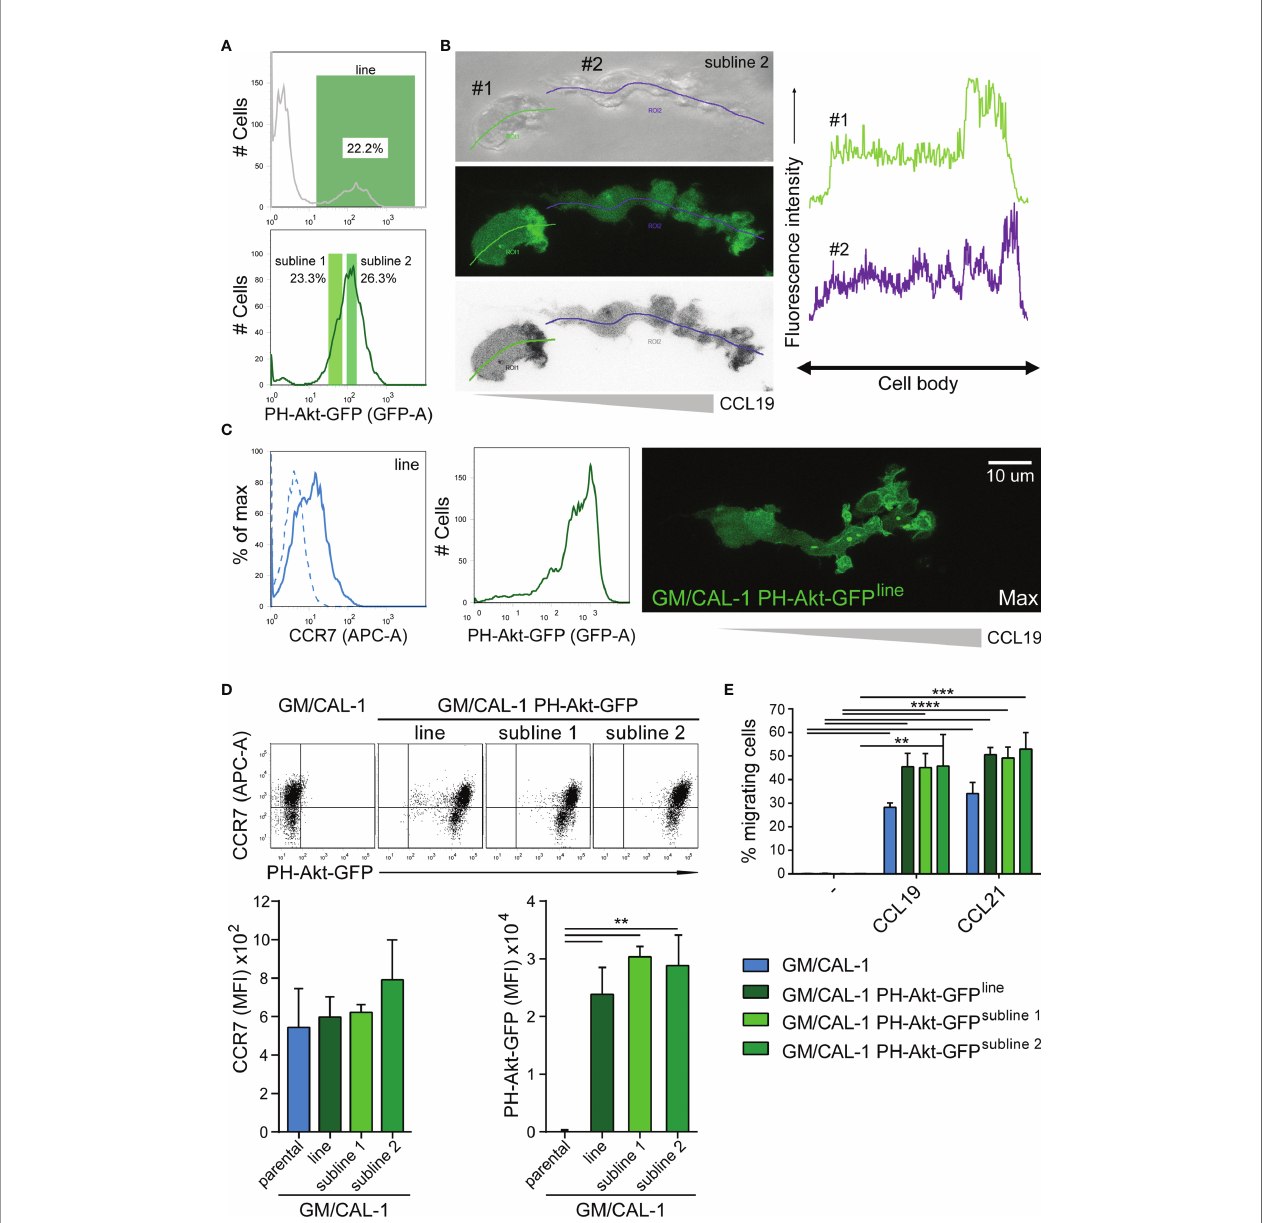
FIGURE 5 | Establishing stable cell lines to monitor PH-Akt-GFP, a biosensor for PIP 3 , in migrating R848-matured GM/CAL-1 cells. (A) Generation of a stable CAL-1 PH-Akt-GFP line and two sublines. CAL-1 cells were nucleofected with a plasmid coding for PH-Akt-GFP. After two weeks of selection, 22.2% of the cell population stably expressed PH-Akt-GFP and was bulk sorted (upper panel), revealing a stable line termed CAL-1 PH-Akt-GFP line . After 21 days in culture under G418 selection, two sub-lines were generated according to the gating strategy shown in the lower panel. (B) PH-Akt-GFP accumulates at the leading edge of migrating cells. R848- matured GM/CAL-1 PH-Akt-GFP subline 2 cells were embedded in 3D collagen and allowed to migrate towards CCL19. Bright fi eld (upper left panel), GFP- fl uorescent confocal (middle left panel), and inverted gray scale confocal (lower left panel) image of two individual migrating cells are shown. Line scan plots for PH-Akt-GFP along the cell axis of the two cells are depicted in the right panels. (C) Surface expression of CCR7 (left fl ow cytometry panel; blue solid line; isotype control: dashed line) and PH- Akt-GFP fl uorescence (right fl ow cytometry panel) in R848-matured GM/CAL-1 PH-Akt-GFP line cells was determined by fl ow cytometry. Maximal PH-Akt-GFP projection of a cell migrating through a 3D collagen I matrix along a CCL19 gradient is shown on the right. The corresponding time-lapse confocal microscopy video 1 can be found in the supplement. (D) CAL-1 PH-Akt-GFP (sub)lines retain their transgene and comparably induce CCR7 upon exposure to GM/CSF and maturation by R848. Representative CCR7/PH-Akt-GFP dot plots (upper panel) and quanti fi cation of all three independent experiments performed with parental GM/CAL-1 cells or GM/CAL-1 PH-Akt-GFP line and sublines, respectively, for CCR7 surface expression (lower left bar graph) and PH-Akt-GFP expression (lower right bar graph) are depicted as mean values ± SEM of median fl uorescence intensities. (E) R848-matured GM/CAL-1, GM/CAL-1 PH-Akt-GFP line , GM/CAL-1 PH-Akt-GFP subline 1 , or GM/CAL-1 PH-Akt- GFP subline 2 migrate in response to 30nM CCL19 or 30nM CCL21 in a 2D Transwell chemotaxis assay. Percentage of migrated cells was determined by fl ow cytometry after 3h of migration. Mean values ± SD of 3 independent experiments are